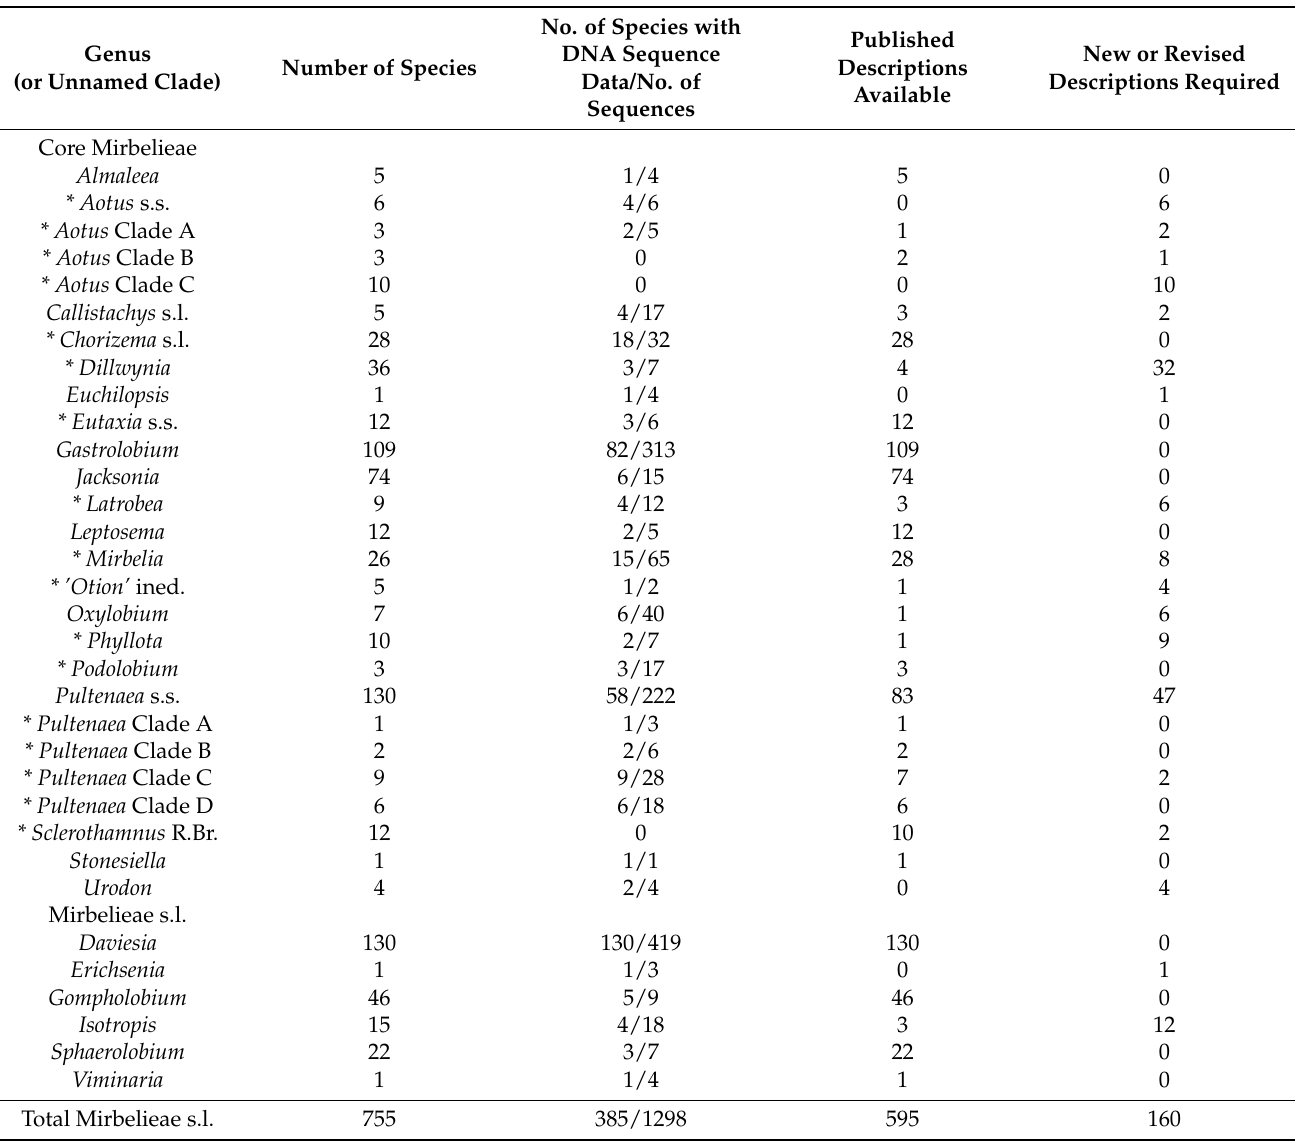
Table 4. Summary of genera in tribe Mirbelieae reflecting putative phylogenetic relationships, number with molecular data, and progress towards eFlora treatments. Genera or clades marked with an * are yet to be adequately circumscribed and require additional genetic